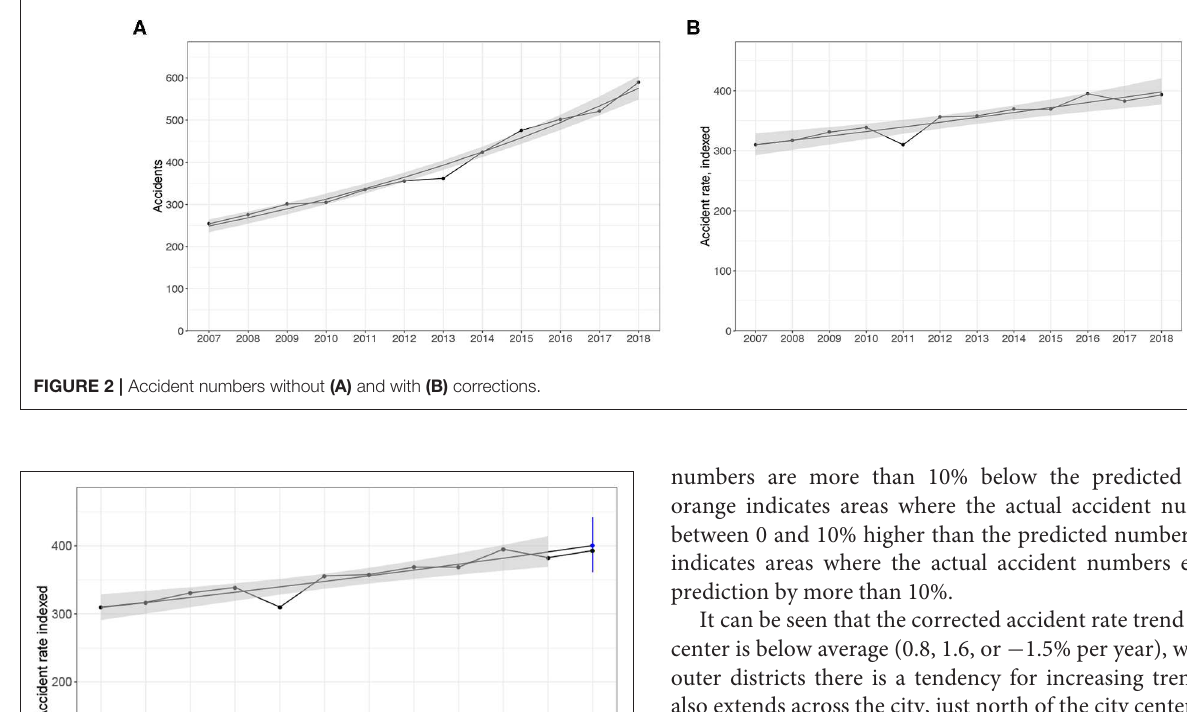
accidents in 2018 ( Figure 3 ). This is indicated by the fact that the last data point lies within the blue bar, which represents the 95% prediction range for the next